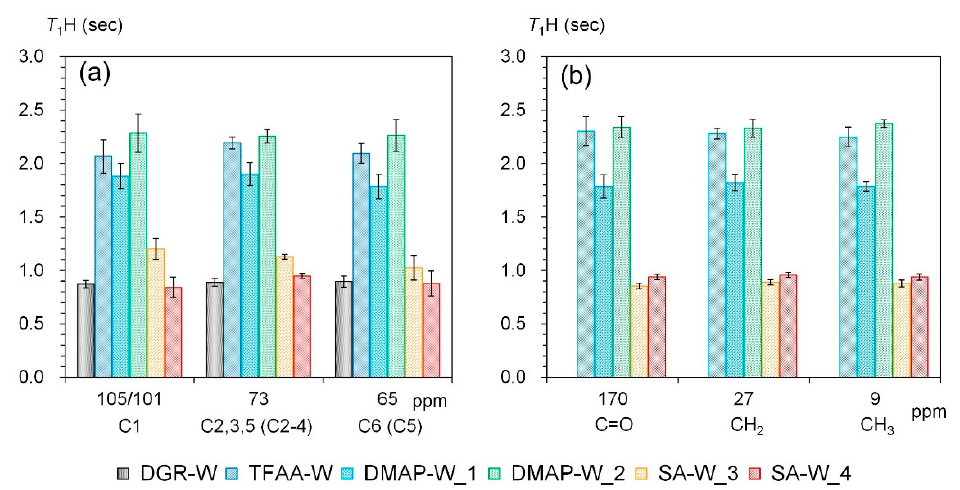
Figure 14. 1 H spin-lattice relaxation time in the laboratory frame ( T 1 H) of degreased and propionylated wood samples in the dry state: ( a ) carbohydrates, ( b ) propionyl group (error bars show the standard deviation from the mean of five measurements).